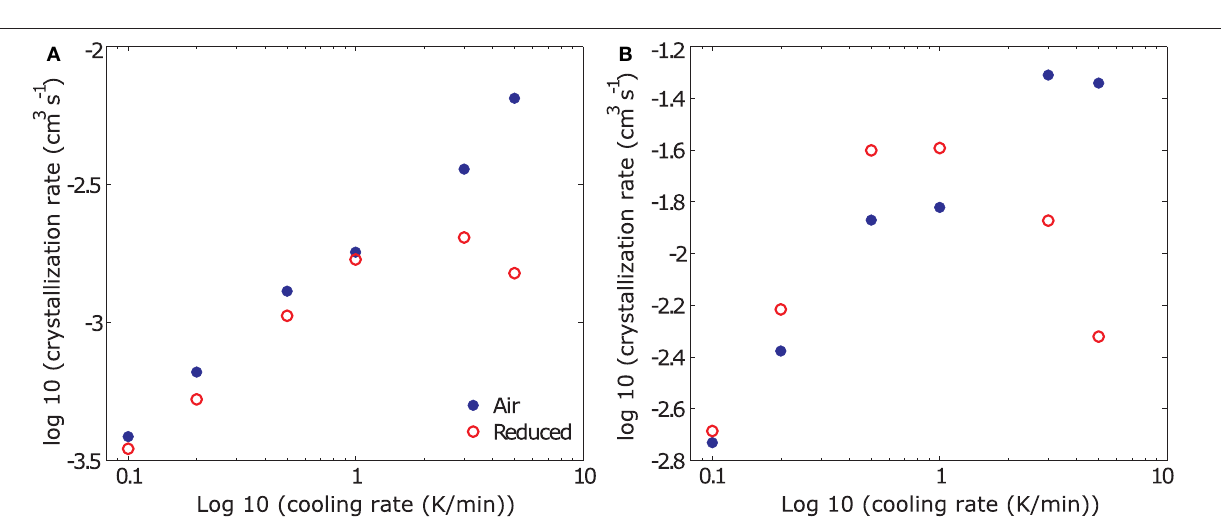
FIGURE 8 | Results from the deduction of average (A) and maximum (B) volumetric crystallization rates from rheological data presented in log-log space. At cooling rates < 1 K/min, average crystallization rates (A) are similar independent of fO 2 conditions, at cooling rates > 1 K/min, the average crystallization rates under reduced conditions drastically decreases - indicating the initiation of glass formation rather than crystallization. At cooling rates < 1 K/min, maximum crystallization rates (B) increase with decreasing fO 2 and are higher than those measured in air, whereas at cooling rates > 1 K/min, maximum crystallization rates plummet under reducing conditions in a similar way as the average crystallization